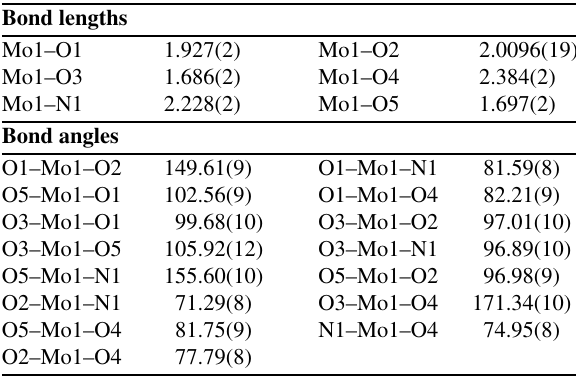
Table 2. Selected bond lengths (Å) and angles (°) for the